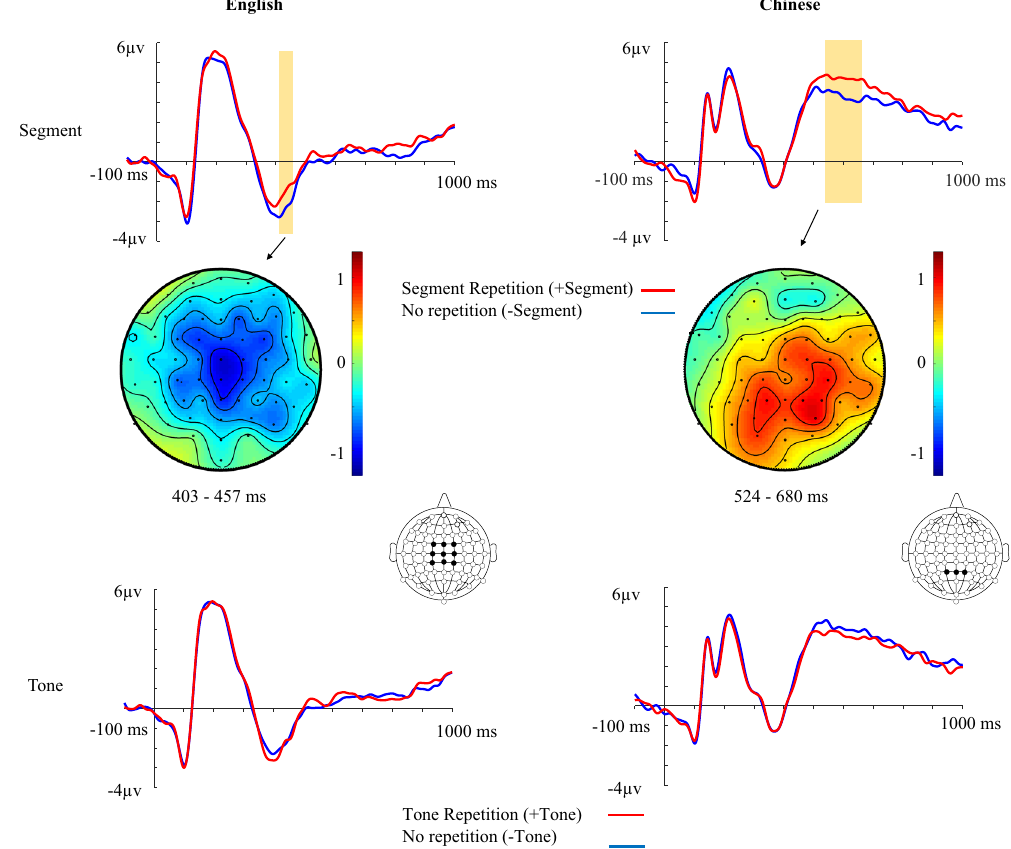
Figure 1. Results of ERP analyses of English (left) and Chinese (right) experiments. ERPs time-locked to the onset of target words (English experiment: averaged across 9 electrodes FC1, FC2, FCz, C1, C2, Cz, CP1, CP2, CPz, Chinese experiment: averaged across 3 electrodes, Pz, P1, P2) with topography of ERP